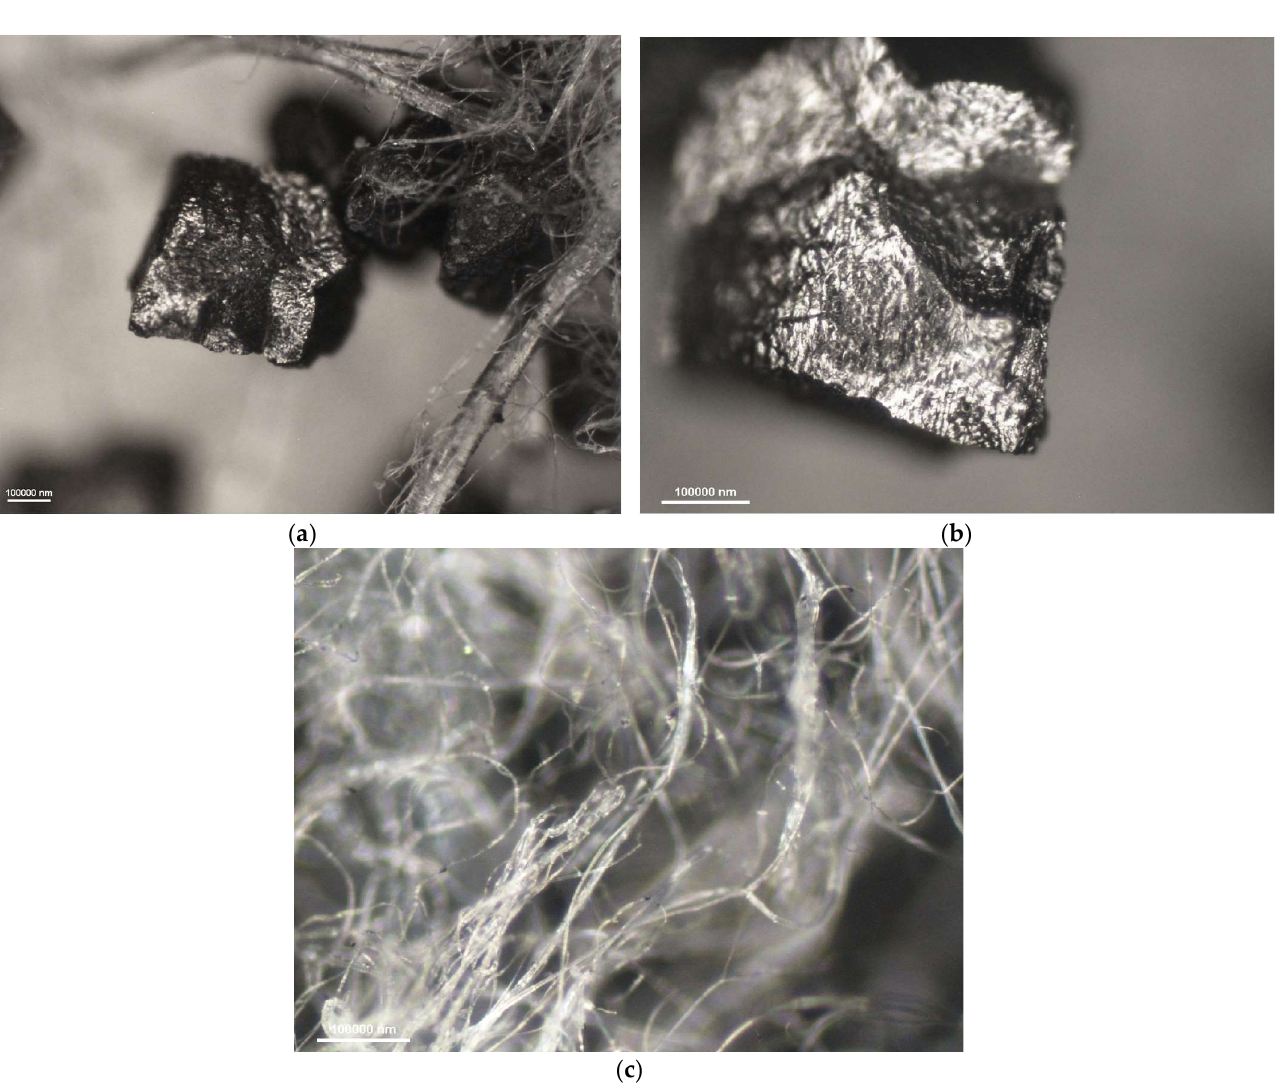
Figure 7. Photomicrographs of adsorbing nonwoven from half-mask 2 at a magnification of ( a ) ×50 and ( b ) ×100 .